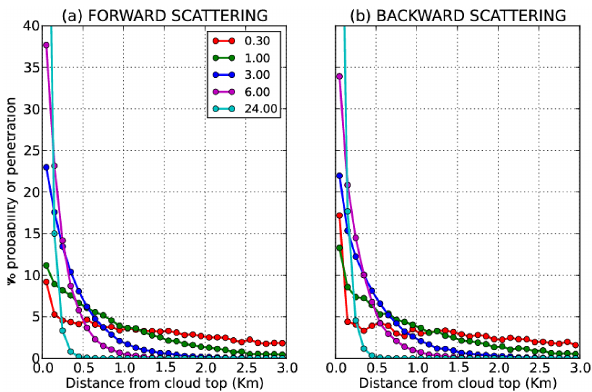
Figure 12. The percent (%) probability of the penetration depth of solar radiation at 0.865µm as a function of distance from the cloud top (km), and cloud optical depth for (a) forward-scattered and (b) backward-scattered solar radiation in the principal plane, respec- tively. The percent probability of penetration is defined as the last position (distance from the cloud top) of the photon before leaving the cloud to reach the sensor. The cloud optical depth colour scale is defined by the key shown on the upper right-hand side of (a)